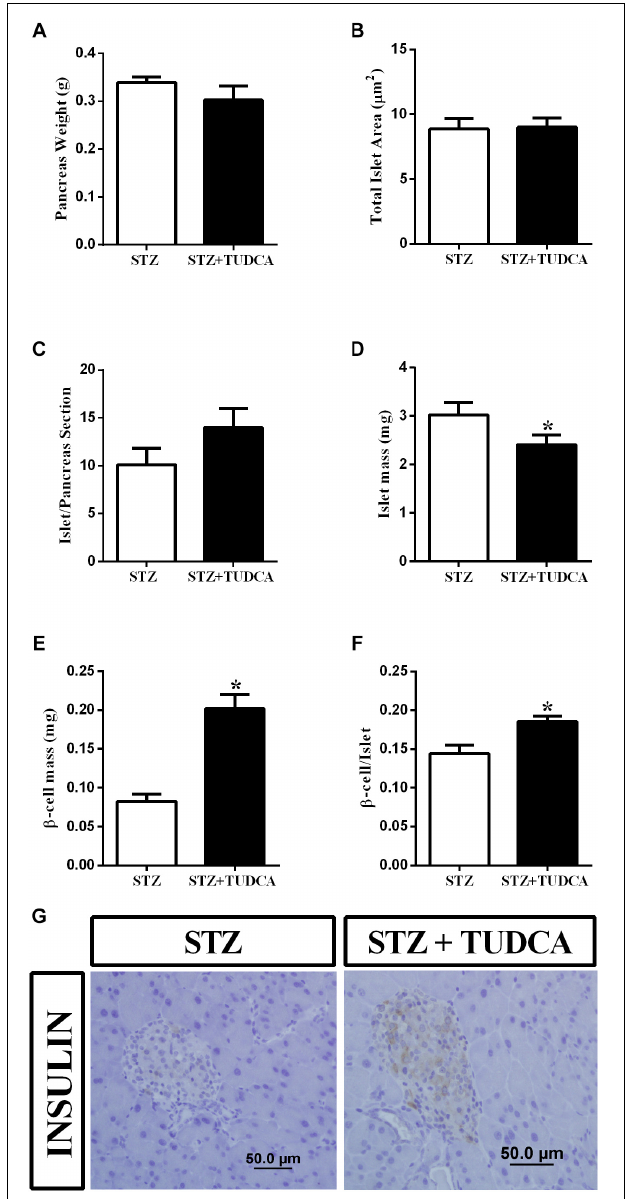
FIGURE 5 | TUDCA treatment increases beta-cell mass and beta-cell number per islet in early-stage T1D mice. Pancreas weight (g) (A) ; total islet area ( µ m 2 ) (B) ; islet/ pancreas section ratio (C) ; islets mass (mg) (D) ; beta-cell mass (mg) (E) ; beta-cell/islet ratio (F) of STZ (white bar, n = 4) and STZ+TUDCA (black bar, n = 4) mice. Representative images of pancreas sections stained for insulin (G) . Data are the mean ± SEM. ∗ P ≤ 0.05 (Student’s t -test or Mann-Whitney